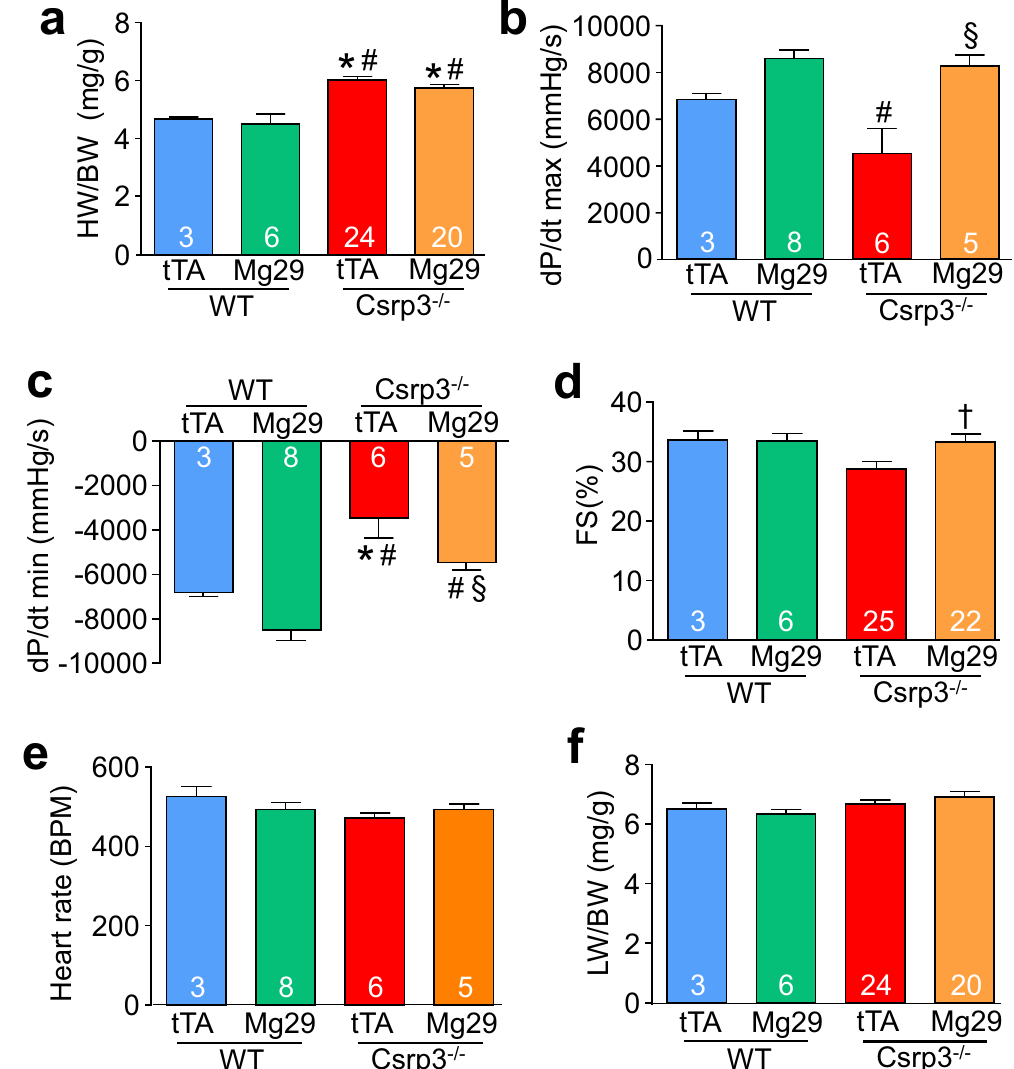
Figure 3. Transgenic expression of Mg29 improves cardiac functional performance in mice lacking MLP protein. ( a ) Heart weight normalized to body weight (HW/BW), ( b ) systolic function (dP/dt max), and ( c ) relaxation (dP/dt min), ( d ) fractional shortening (FS) percentage, ( e ) heart rate in beats per minute (BPM), and ( f ) lung weight normalized to body weight (LW/BW) measured from low-expressing Mg29 DTG mice, tTA- expressing control mice, and Csrp3 − / − mice expressing either Mg29 or tTA. Number of mice analyzed is shown in the bars of each graph. * P < 0.05 versus tTA (control) group. # P < 0.05 versus Mg29 DTG group. § P < 0.05 versus Csrp3 − / − , tTA group. † P < 0.05 versus tTA Csrp3 − / − group by Student’s t-test, although this difference was not quite significant by